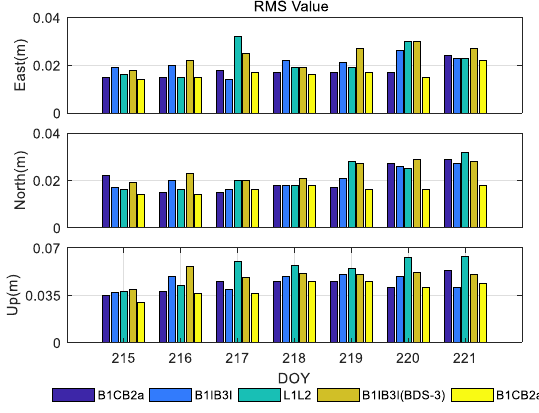
Figure 8. TGD2-TGCU (128 km) long baseline RTK positioning accuracy. Table 6. TGCU–TGBU (30 km) average of medium baseline RTK RMS and ambiguity fixing rate. Table 8. TGD2-TGCU (128 km) average of long baseline RTK RMS and ambiguity fixing rate. Fixing Frequency